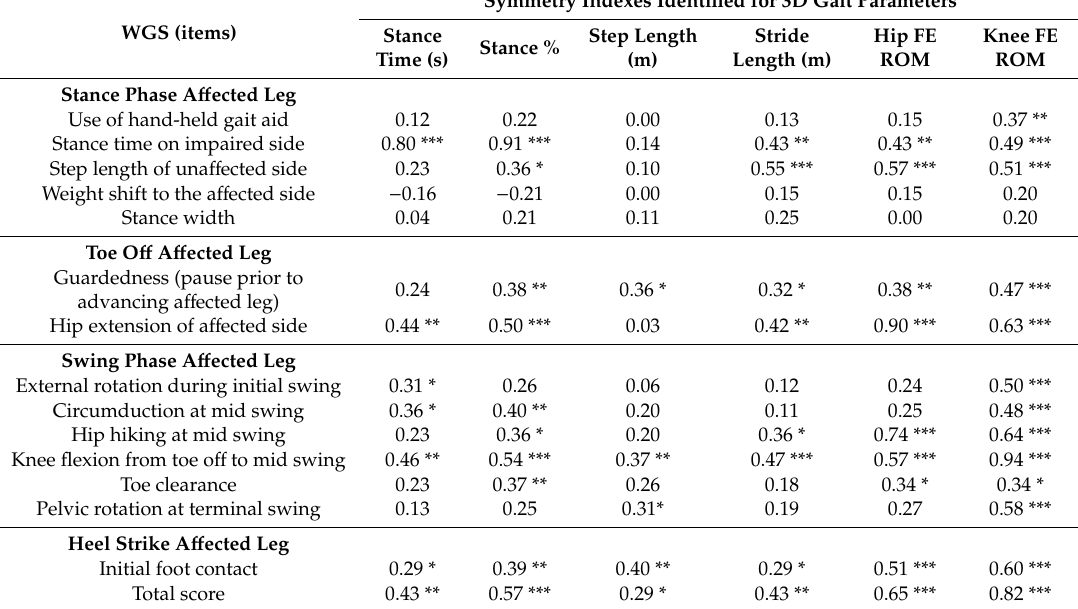
Table 3. Correlations of 3D symmetry indexes to the specific components of and total score in the Wisconsin Gait Scale (WGS).